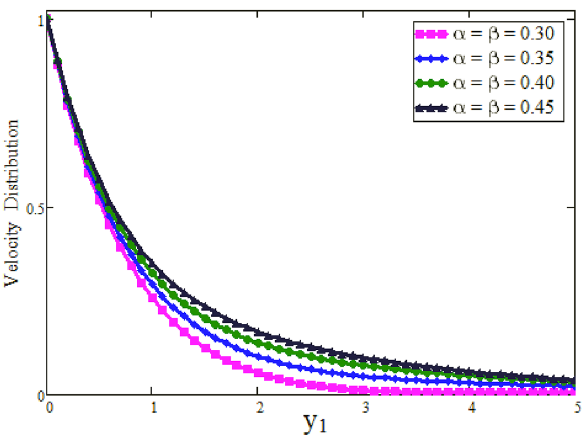
Figure 3. Velocity profile against y 1 due to α for large time, when: t = 0.1 , φ = 0.01 , Pr = 6.2 , Gr = 0.1 and (cid:31) = 0.5.